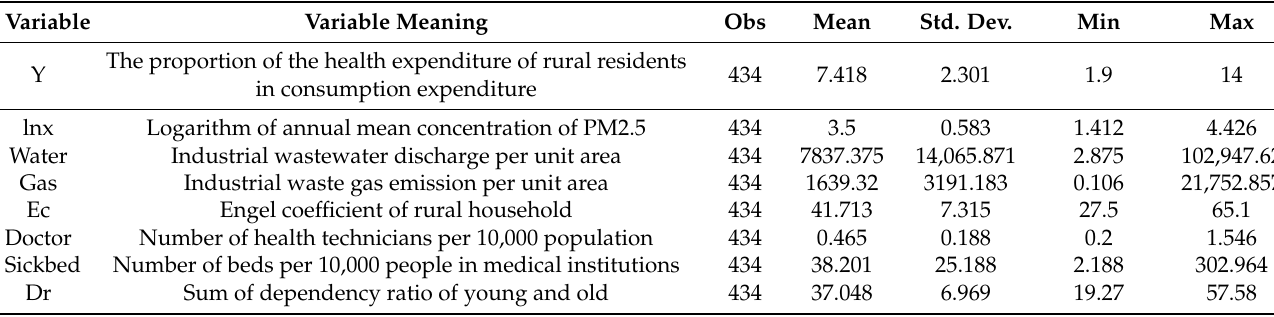
Table 1. Descriptive statistics of variables.